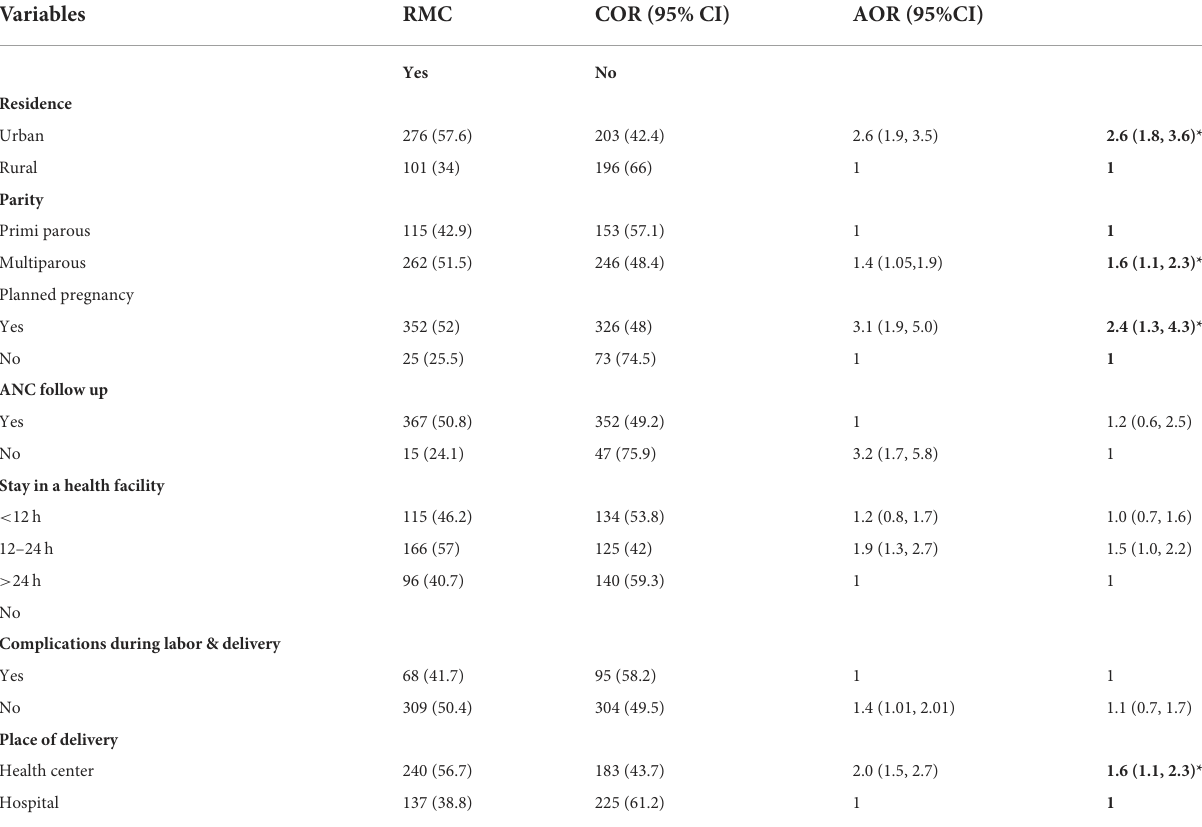
TABLE 3 Bivariate and multivariate logistic regression analysis of RMC among women who gave birth in north Showa zone public health institutions, North Showa zone, Ethiopia, 2020 (N = 776).